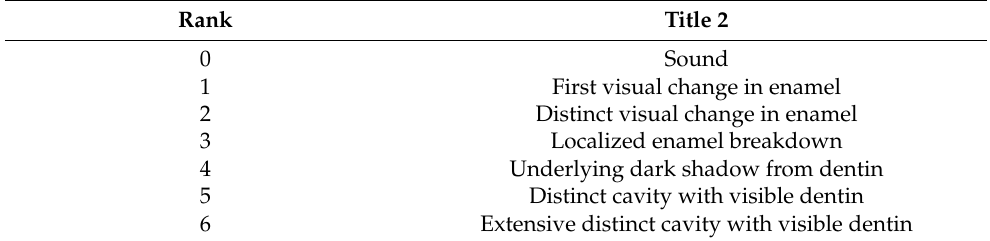
Table 1. ICDAS scoring system used to relate visual appearance of caries to severity